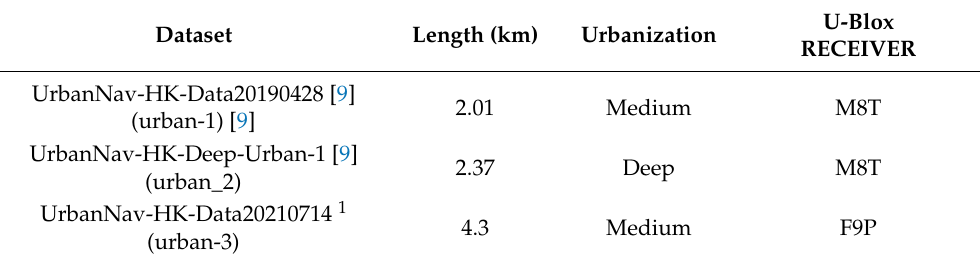
Table 1. The information of the three datasets used for experimental verification in this